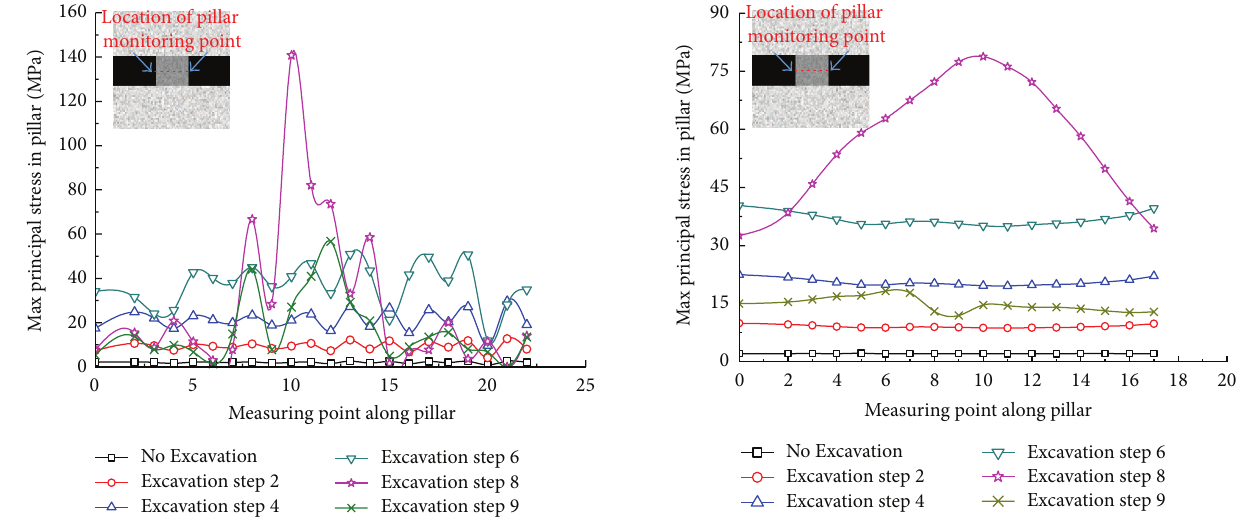
Figure 28: Pattern of stress change within the pillar during the excavation process, 𝑊/𝐻 = 1.5 .